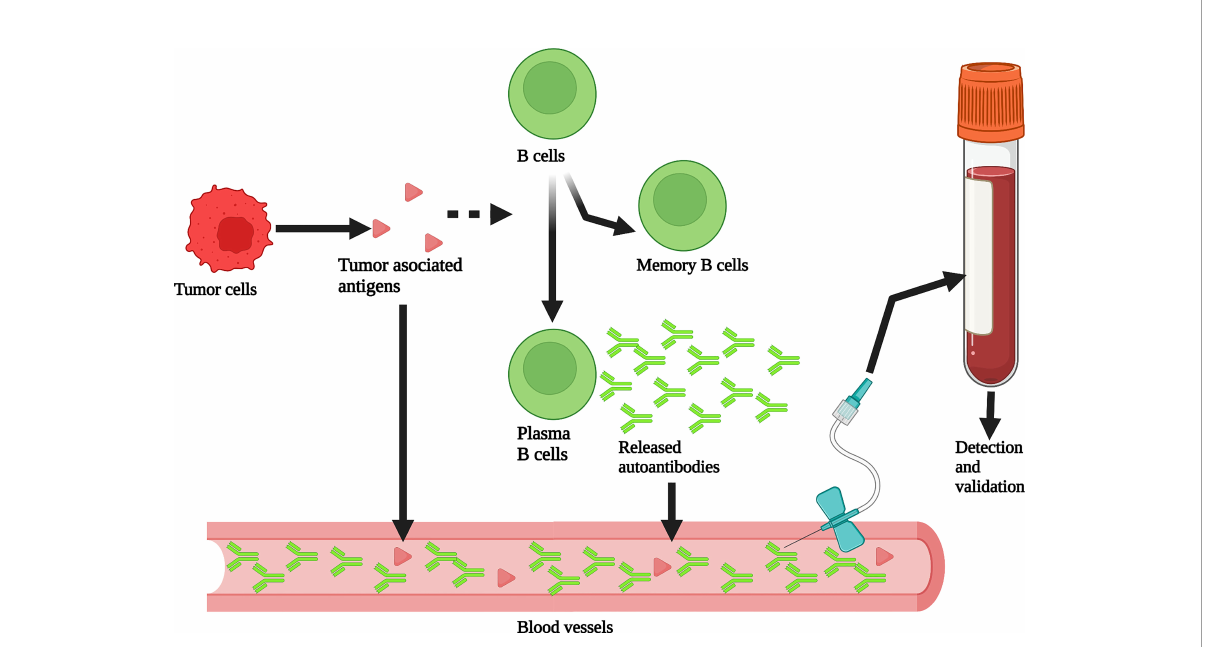
FIGURE 1 Production and detection of peripheral blood autoantibodies. Tumor associated antigens (TAAs) produced by tumor cells stimulate B cells to differentiate into memory B cells and plasma B cells that can produce autoantibodies. These autoantibodies enter the peripheral blood. The abundance of autoantibodies in peripheral blood is much greater than that of TAAs through the ampli fi cation of the immune response process. Therefore, autoantibodies can be detected from plasma or serum to assist in breast cancer screening. Created with